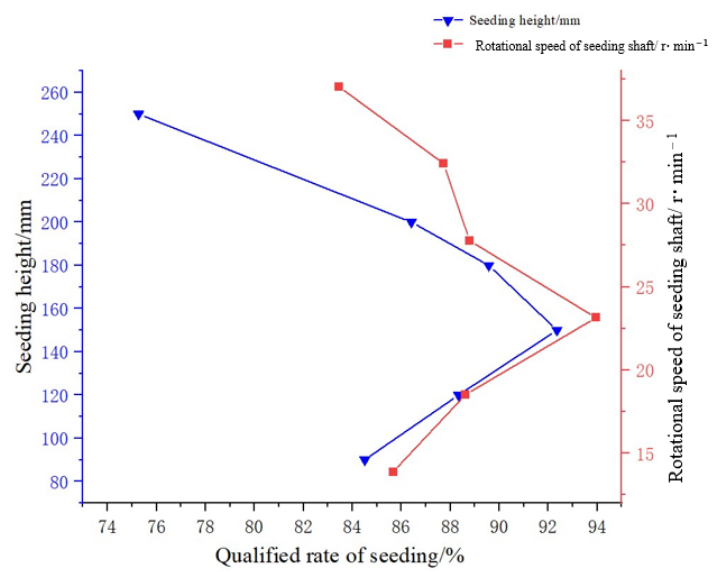
Figure 9. Seed filler performance impact